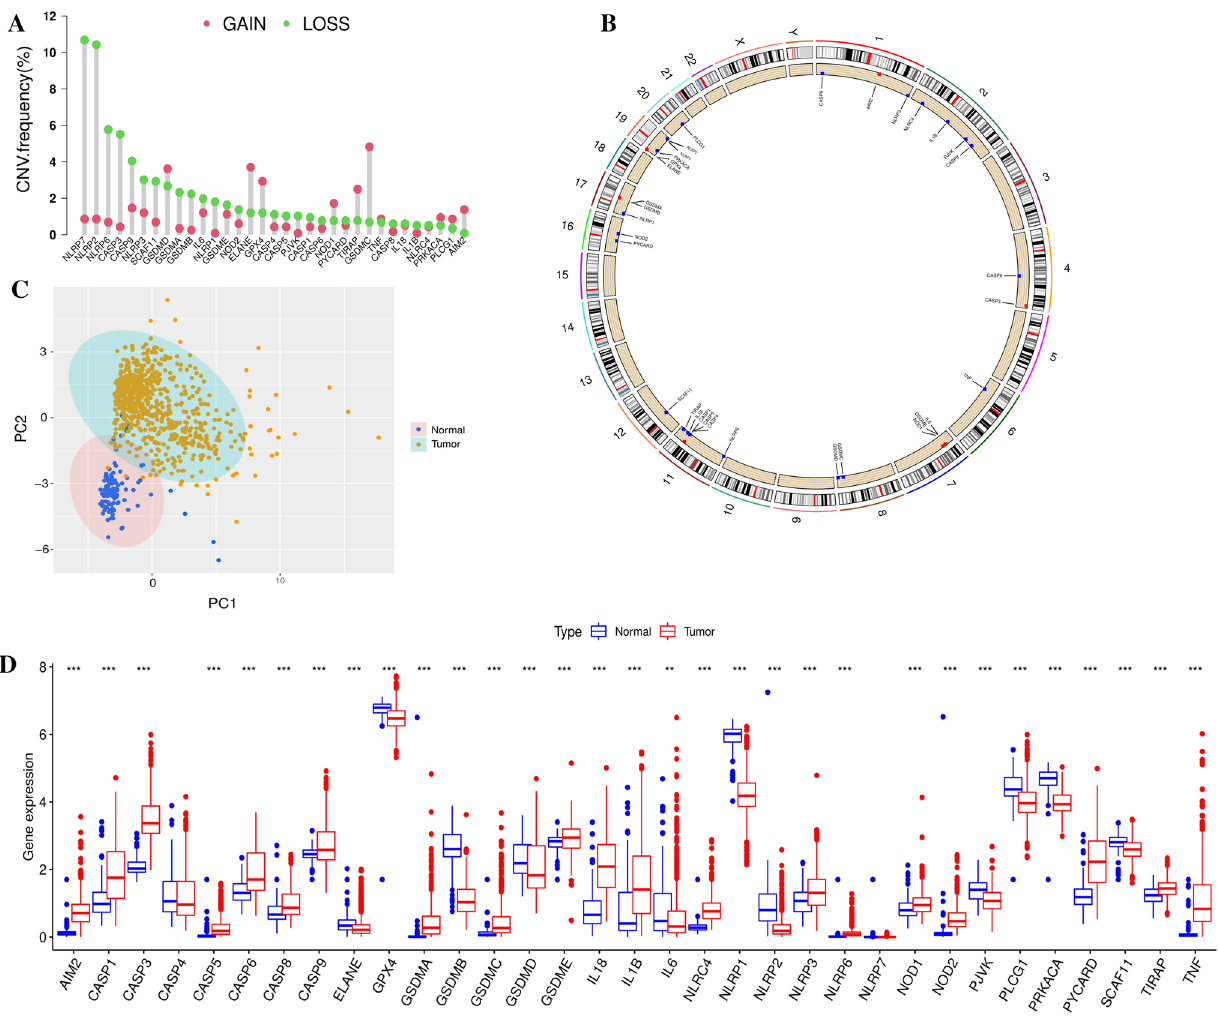
Fig. 1 Genomic and expression variation landscape of pyroptosis-related genes in gliomas. a The CNV mutation frequency of 33 pyroptosis- related genes was widespread. This column represented the variation frequency. Green dots represented deletions; red dots represented amplifications. b The location of 33 pyroptosis-related genes on chromosomes. c Principal component analysis (PCA) was performed on 33 pyroptosis-related genes to distinguish normal from the tumor; normal, blue; tumor, yellow. The expression profiles of 33 pyroptosis-related genes to distinguish tumors from normal samples in TCGA and GTEx cohorts. According to the 33 pyroptosis-related genes expression pro- files, identifying two subgroups without intersection indicated distinct tumors and normal samples. d The different expression levels of 33 pyroptosis-related genes between normal and glioma samples. The statistical p -value was represented by asterisks (* p < 0.05; ** p < 0.01; *** p <